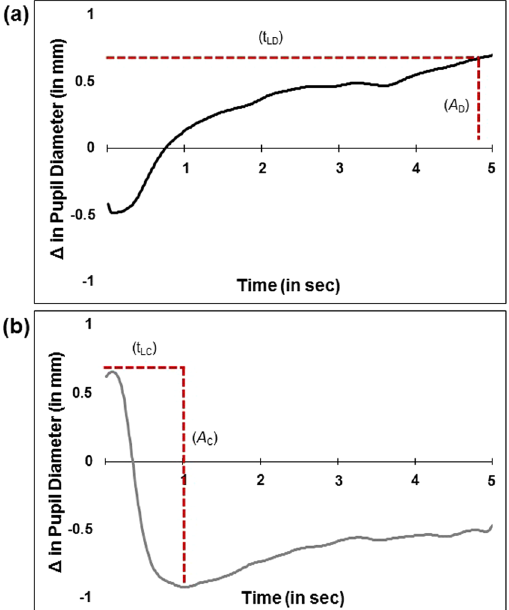
Figure 2. An illustration of the pupillary data from a single participant and pupil metrics (t L and A ) that were extracted individually for each participant across both conditions. ( a ) Latency to reach maximum dilation (t DL ) during the dark condition and amplitude of dilation ( A D ) during the dark condition. ( b ) Latency to reach maximum constriction (t CL ) during the light condition and amplitude of constriction ( A C ) during the light